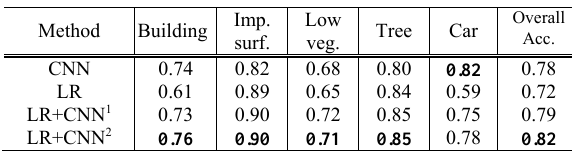
Table 1. Labelling accuracy (F1-scores) of LR classifier